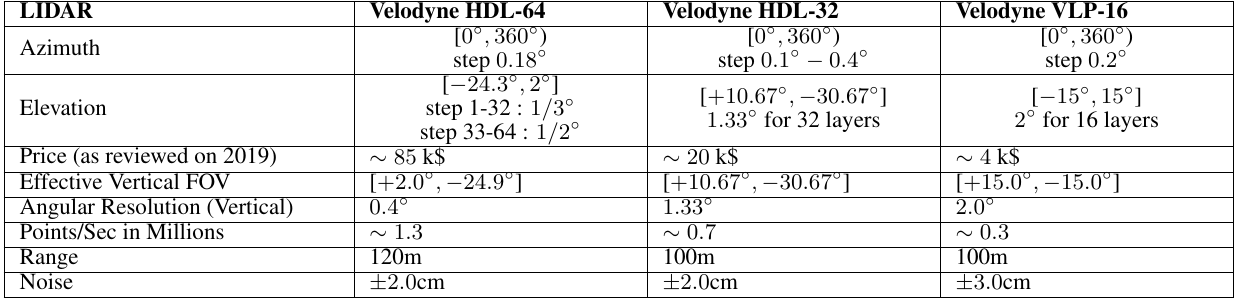
Table 1. Characteristics of different LIDARs from (Velodyne LiDAR, Wikipedia, n.d.). The prices are representative. a large amount of points in